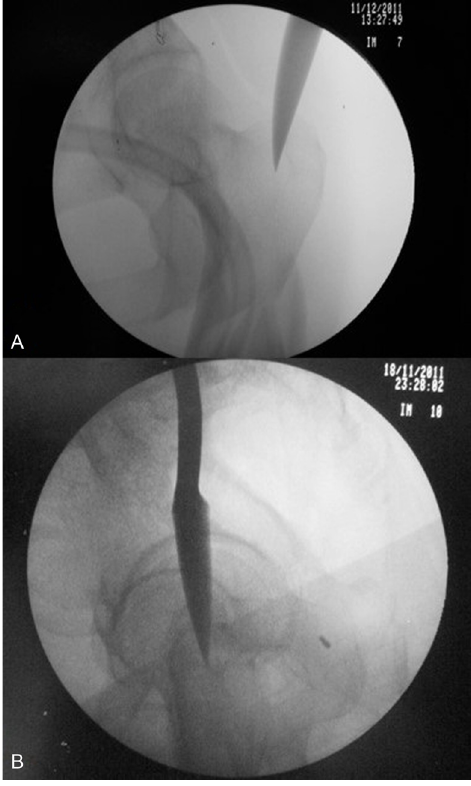
Figure 1. Anteroposterior and lateral fl uoroscopic views of the entry point of gamma nail. In lateral view (b), the C-arm is positioned 10 – 15 ° off the perpendicular plane to the hip to overcome the overlap of the two hips.